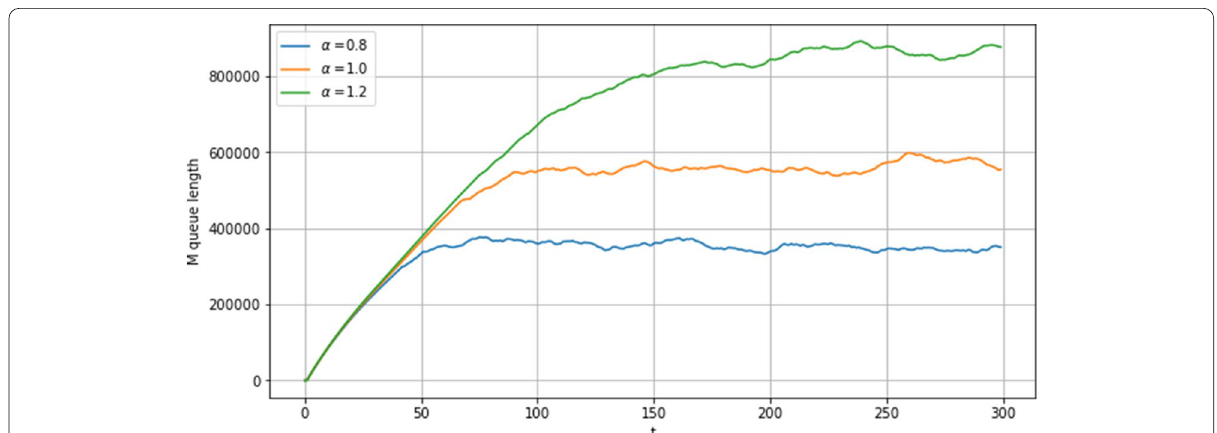
Fig. 5 Queue length of UAVs with different task arrival rate